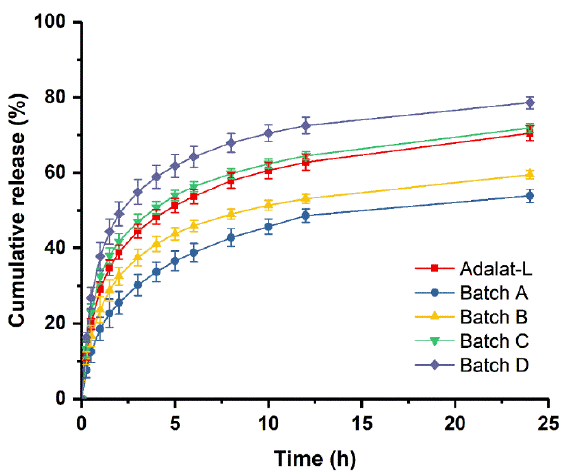
Figure 5. Comparison of in vitro dissolution profiles between prepared tablets and Adalat ® -L ( n = 12).